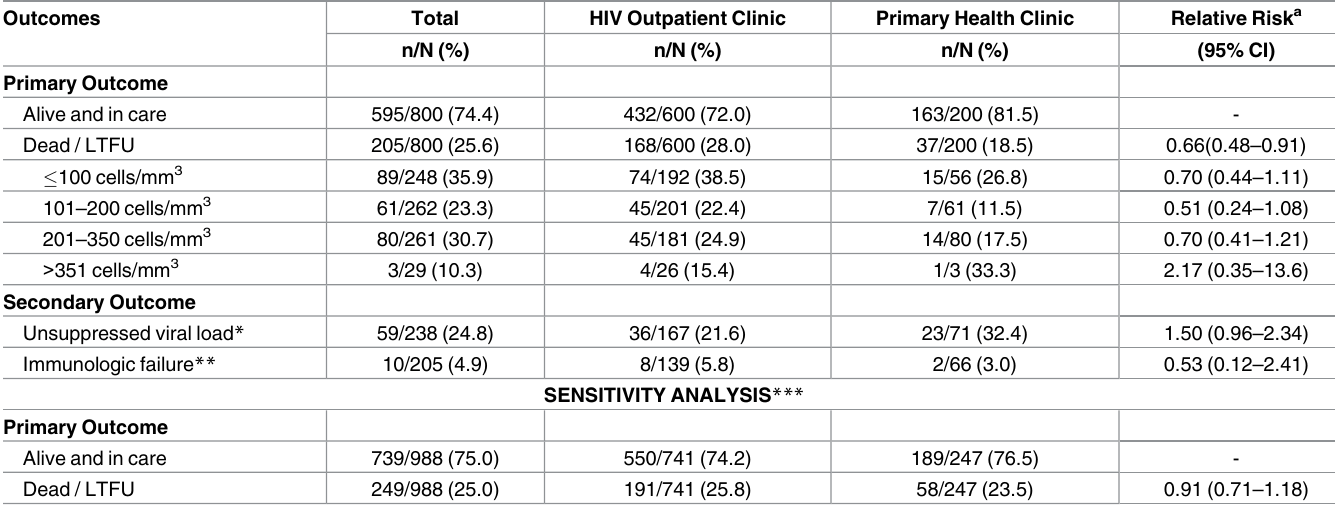
Table 3. Outcomes at 12 months after ART initiation with relative risk.